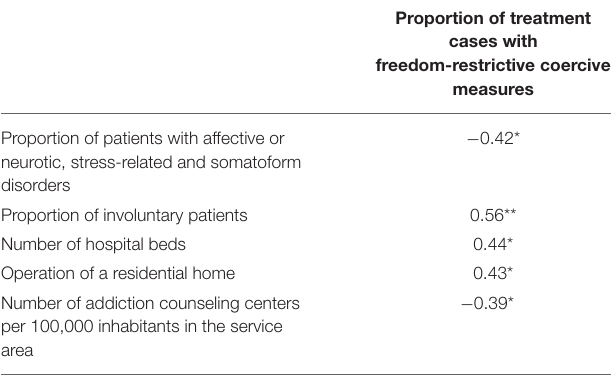
TABLE 2 | Correlation of coercive measures with possible